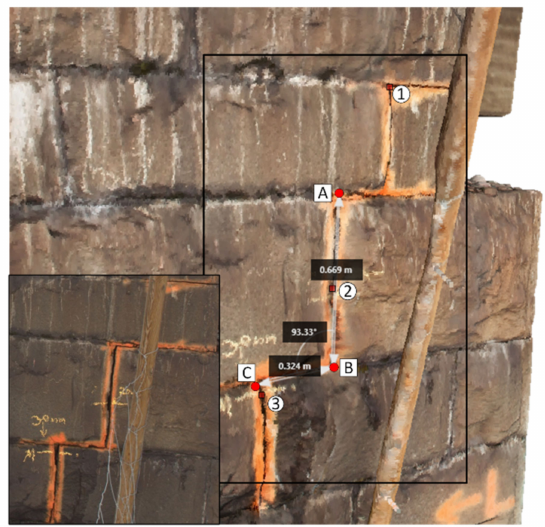
Figure 21. Damage measurement from TLS point